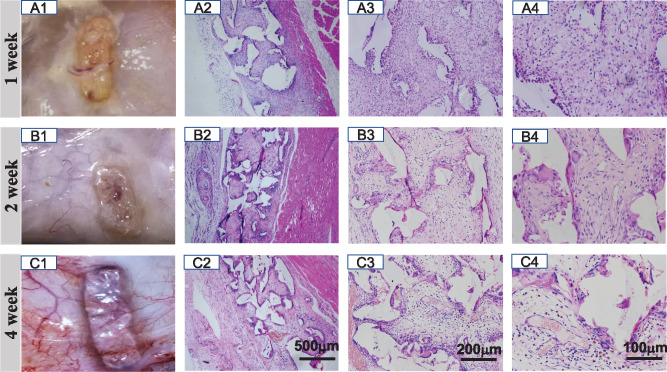

In vivo biocompatibility evaluation of B-PE scaffolds following subcutaneous implantation in rats. Gross view (A1–C1) and H&E staining sections (A2–4, B2–4 and C2–4) after being implanted for (A) 1, (B) 2 and (C) 4 weeks, respectively. The B-PE scaffolds could be recognized as a white porous structure with tissue in growth, collagen deposition and neovascularization